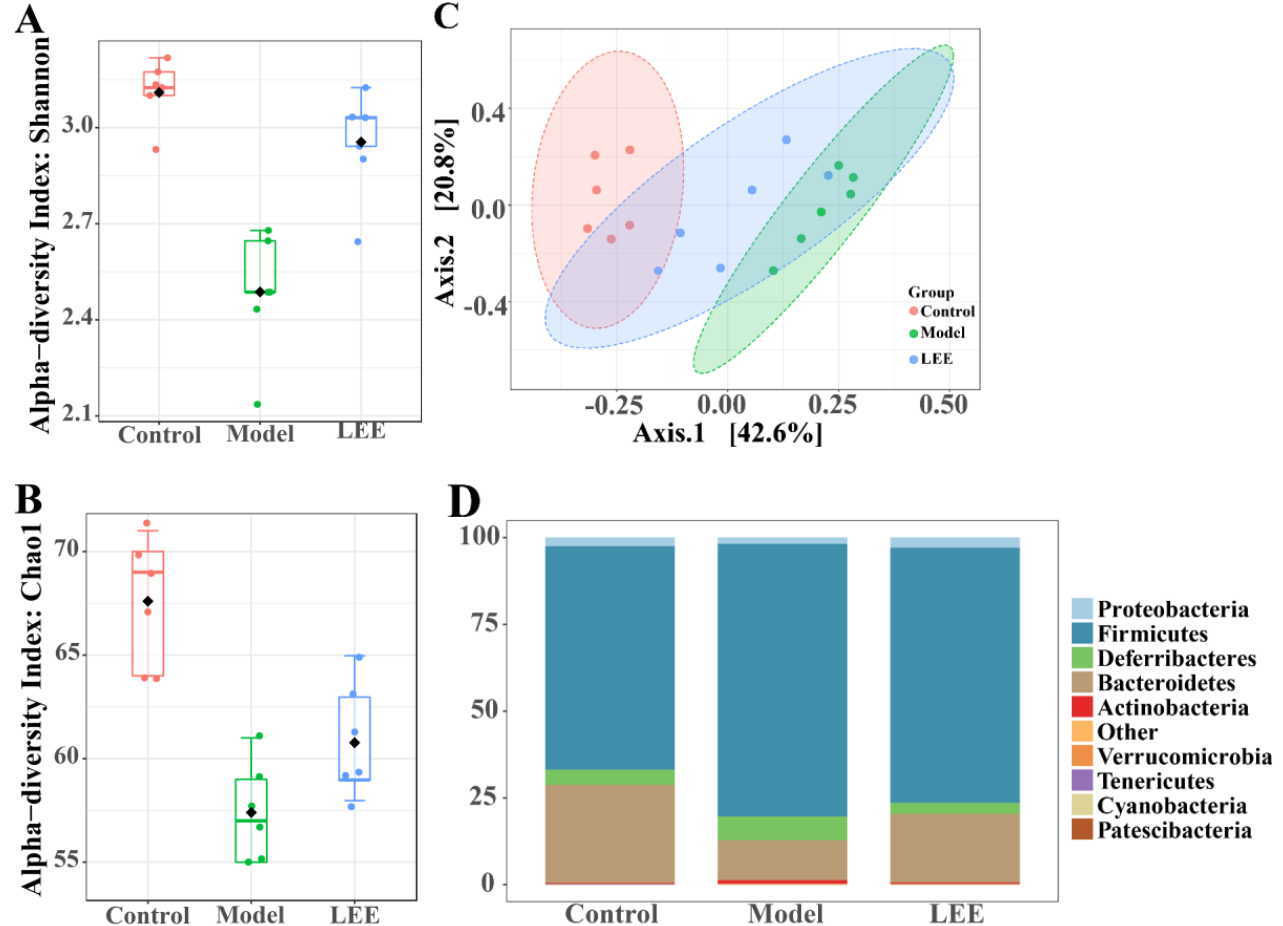
Figure 4. LEE alters the composition of intestinal flora in HFD mice. Shannon ( A ) and Chao1 ( B ) indexes indicate alpha diversity. Principal coordinates analysis of microbial taxa ( C ). Relative